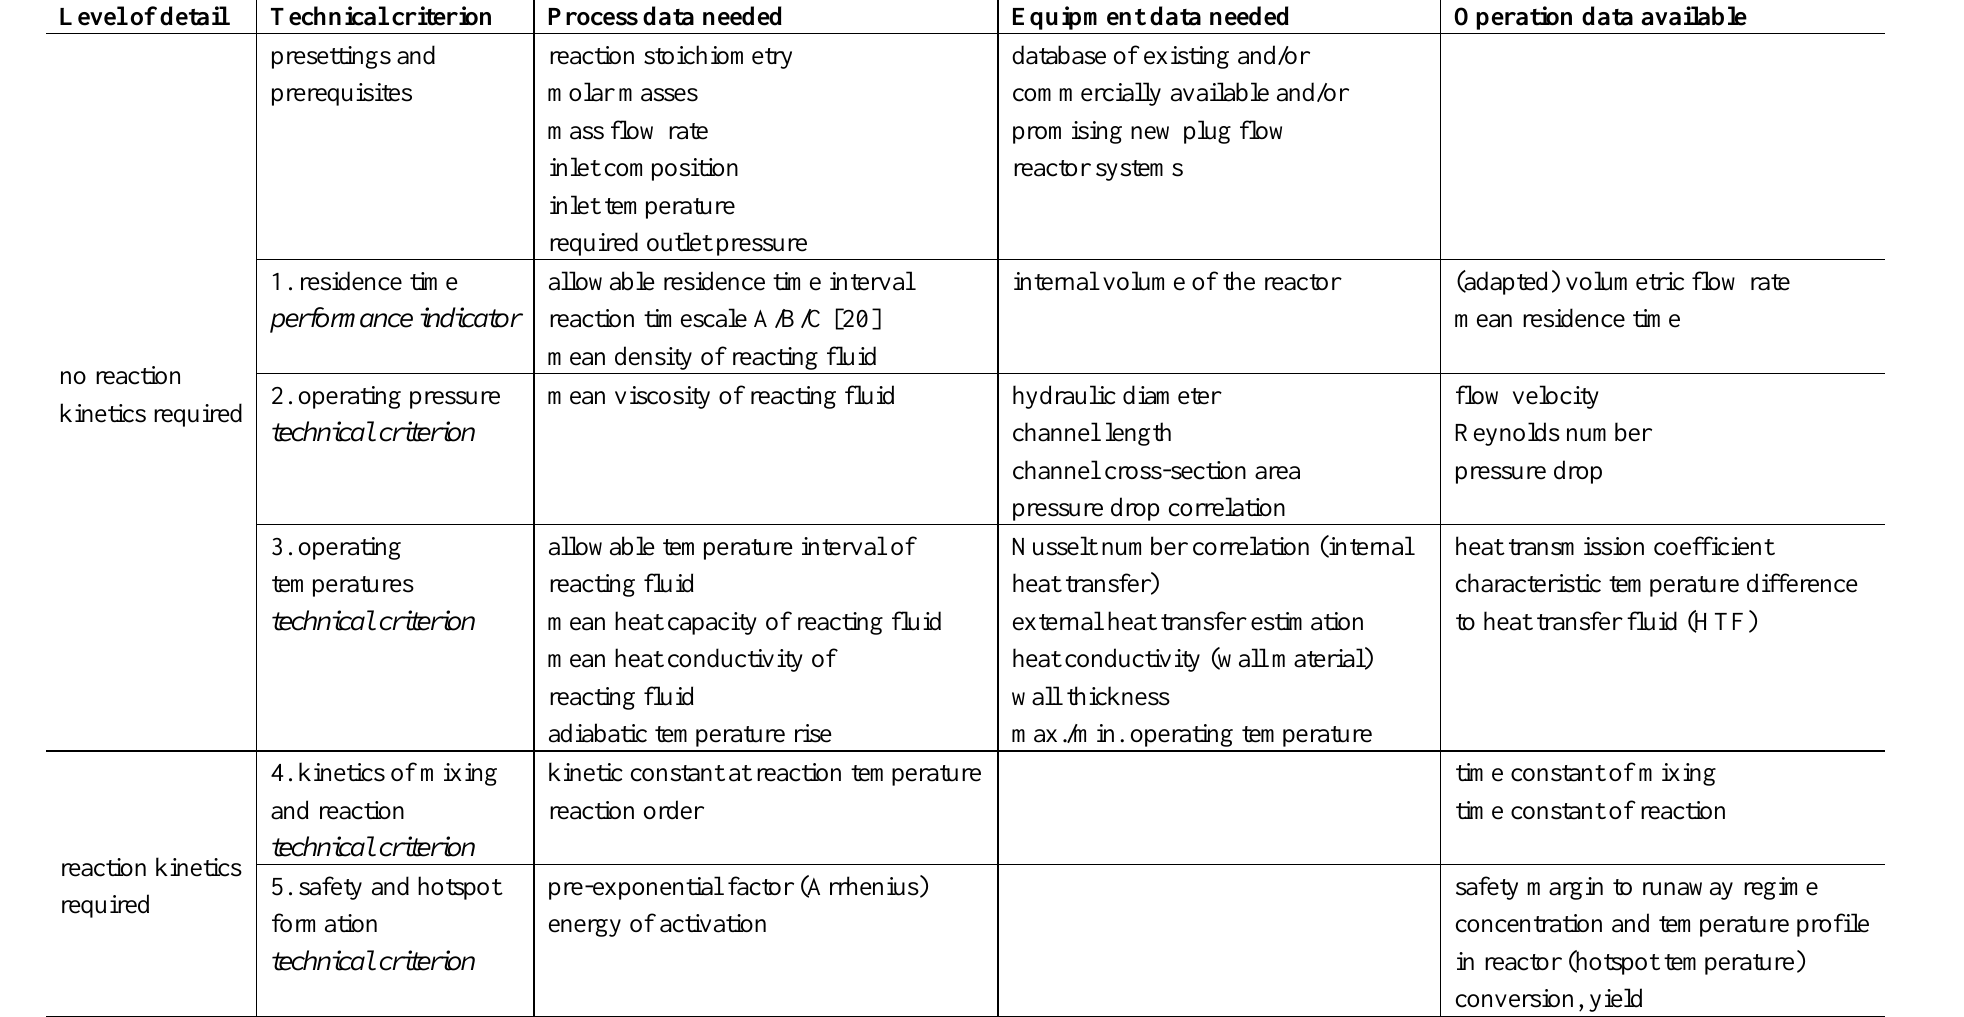
Table 1. Stepwise methodology to preselect standardized technical plug flow reactor systems from a